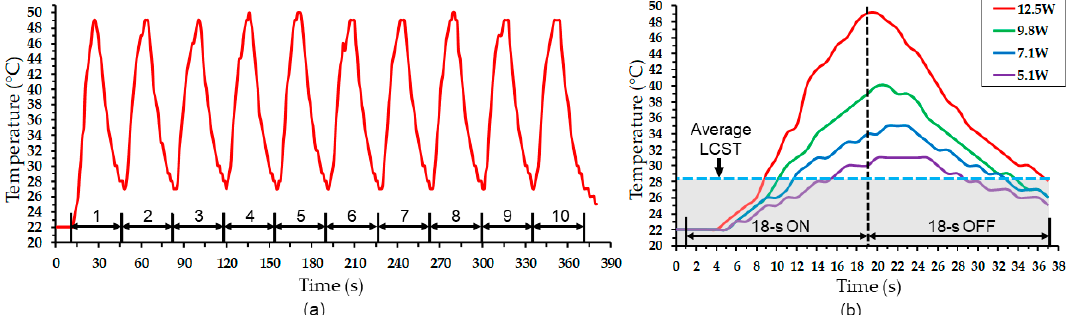
Figure 7. Temporal electrothermal response of the device evaluated by iterative cyclic powering, showing ( a ) the result of ten powering cycles with a fixed power and ( b ) a close-up of single cycle measured with varying input powers.